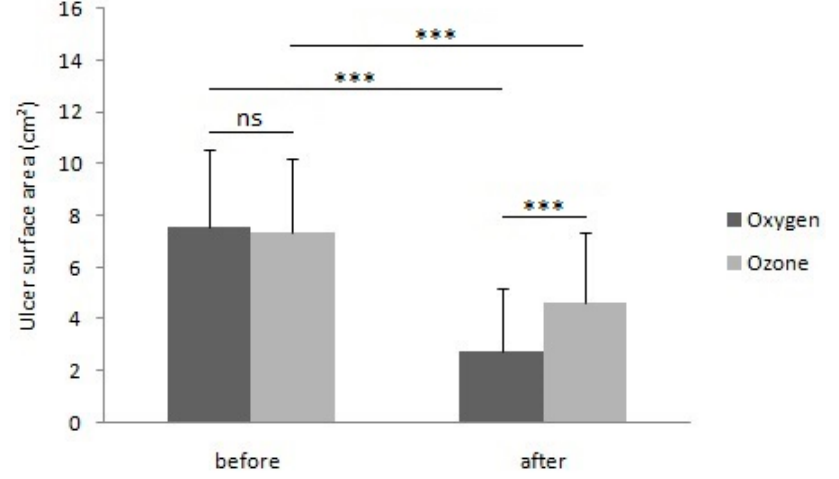
Figure 1. Comparison of results of surface area measurements for venous leg ulcers in patients treated with local hyperbaric oxygen therapy and local ozone therapy, before and after the treatment cycle. (ns: Not significant; *** p < 0.001).